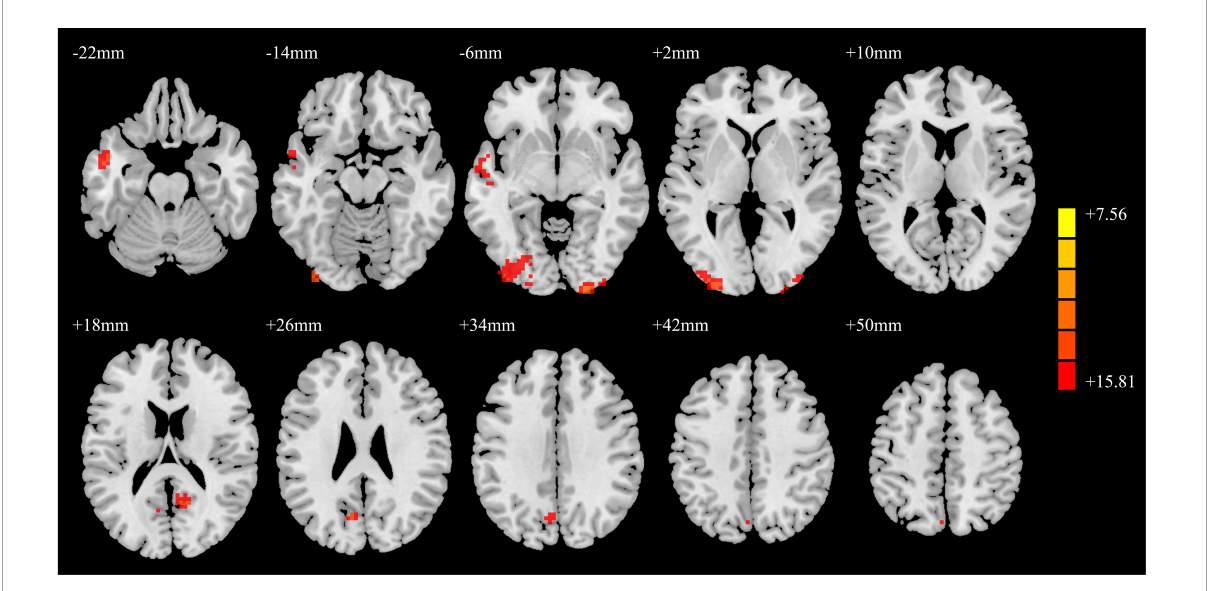
FIGURE3 ANCOVA results of functional connectivity in the PD-MH, PD-NH, and HC groups. Red and yellow indicated altered functional connectivity. Using GRF correction, voxel level P < 0.001 and cluster level P < 0.05 were considered statistically significant difference. ANCOVA, analysis of covariance; PD, Parkinson’s disease; MH, minor hallucination; NH, no hallucinations (and delusions); HC, healthy control; GRF, Gaussian random field.